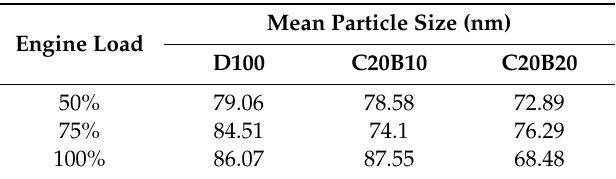
Table 8. Mean size of the produced solid